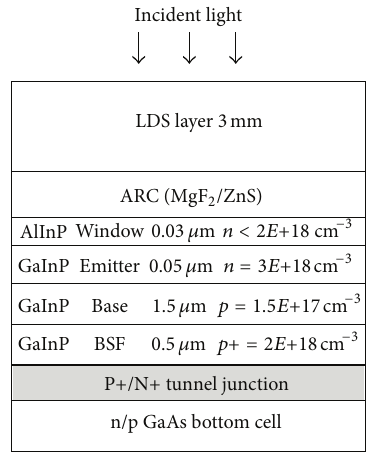
Figure 2: Schematic of a multijunction solar cell with LDS